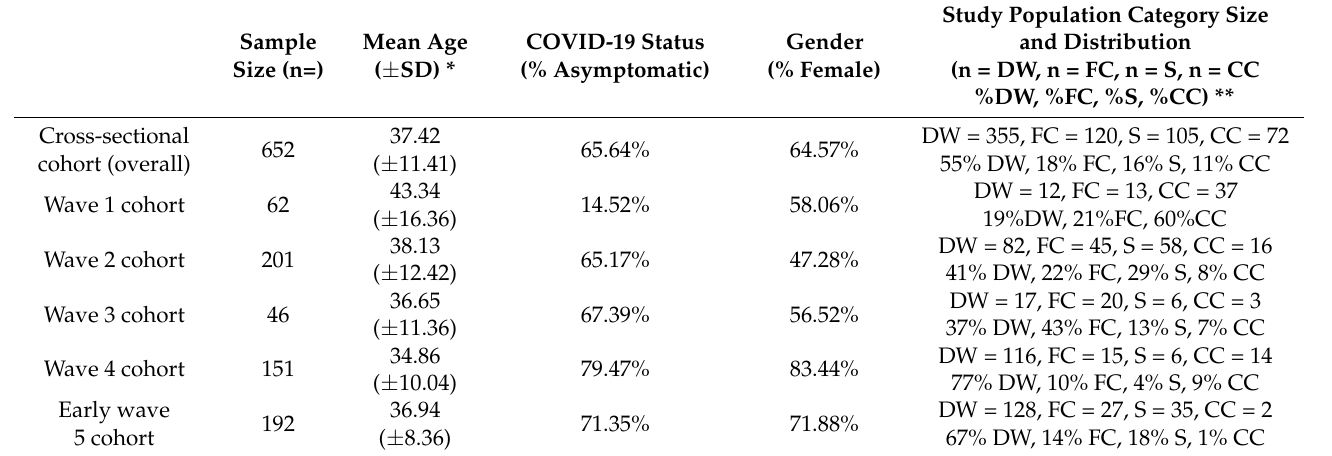
Table 3. Descriptive Statistics of Demographic